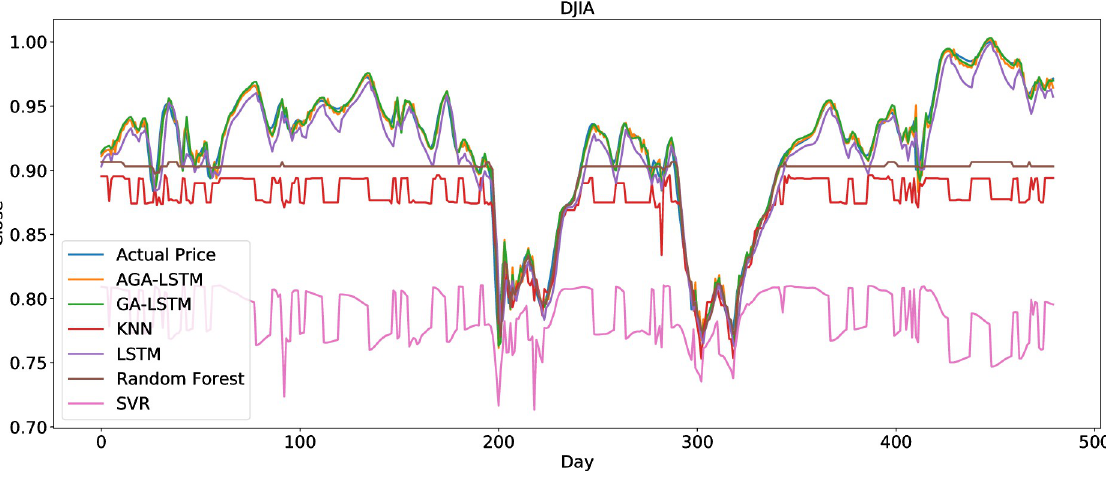
Fig 18. Comparison of AGA-LSTM and other DL models in DJIA data